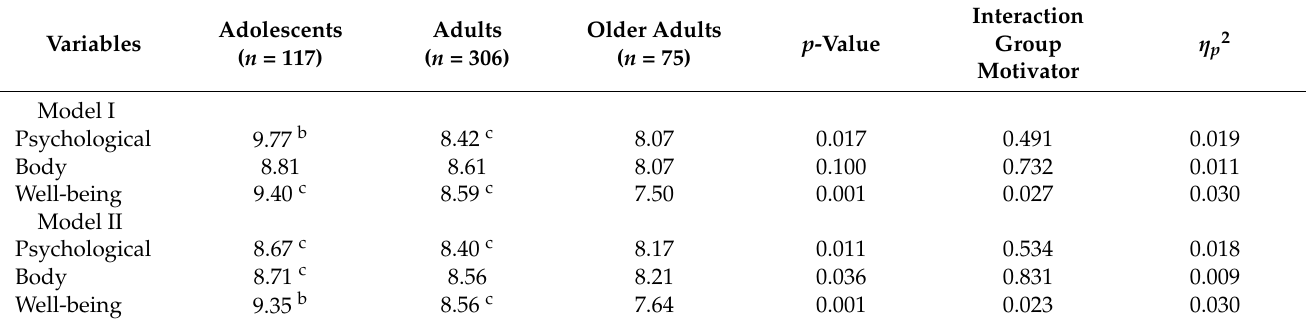
Table 3. Results of univariate ANOVA analysis (unadjusted) and ANCOVA analysis